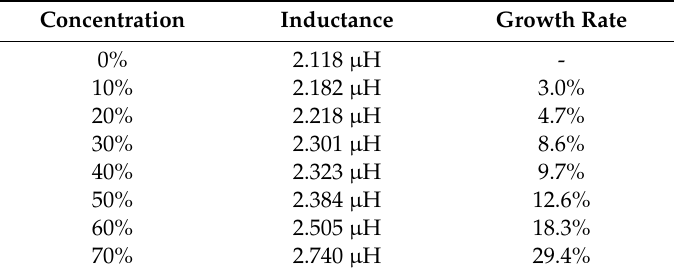
Table 1. The basic inductance of the chips used in the experiment.